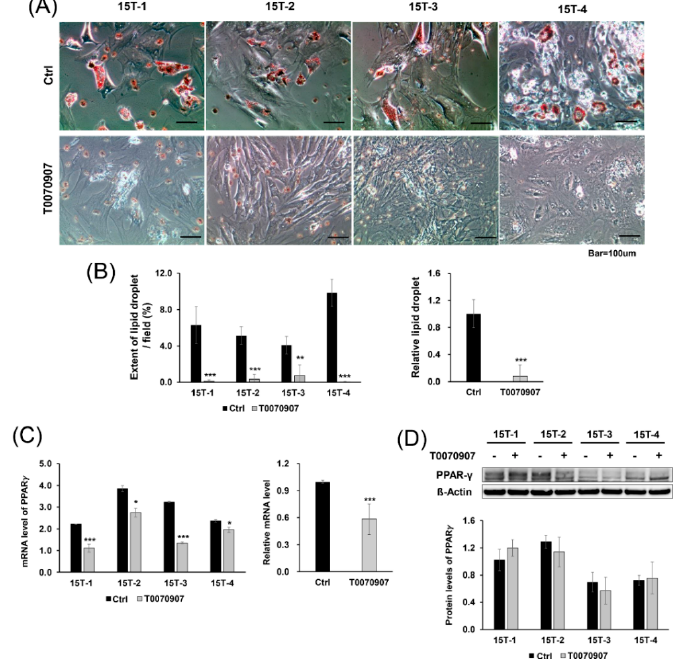
Figure 4. E ff ect of T0070907 on adipogenesis. ( A ) Representative microscopic images of TDSCs cultured with and without T0070907 for 21 days. TDSCs were incubated with 0.3% Oil Red O solution, and ( B ) extent of lipid droplet per field was measured the stained areas using ImageJ. The relative lipid droplet represents the value divided the extent of lipid droplet in the T0070907 treatment group by the extent of lipid droplet in the control group in all of the cells. Lipid droplets were decreased in the presence of T0070907. T0070907 e ff ects on the expression of peroxisome proliferator-activated receptor gamma (PPAR γ ) were measured by ( C ) qRT-PCR and ( D ) Western blot. ( C ) qRT-PCR analysis showed decreased mRNA levels of PPAR γ in the presence of T0070907, ( D ) whereas Western blot analysis presented no significant change in protein levels of PPAR γ . The relative mRNA level represents the value divided PPAR γ mRNA level of the T0070907 treatment group by PPAR γ mRNA level of the control group in all of the cells. mRNA level of PPAR γ represents mRNA expression levels standardized to β -actin, and protein level of PPAR γ represents normalized protein expression level by β -actin. Error bars represent the standard deviation of mean. * p < 0.05, ** p < 0.01, *** p < 0.001, compared with T0070907 group and control